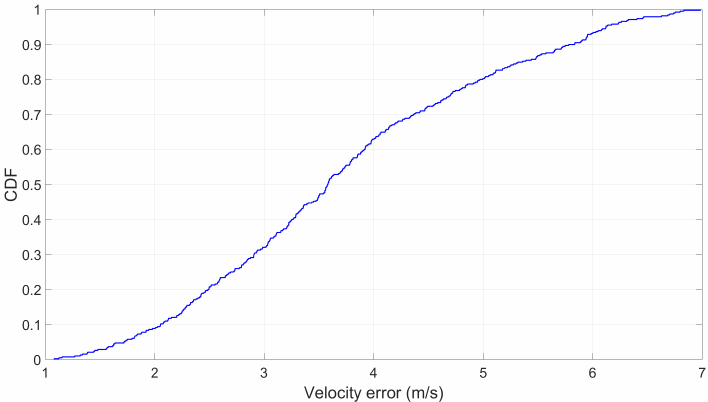
Figure 17. The velocity error with the stopping references: This is what the estimated speed is when the train has actually